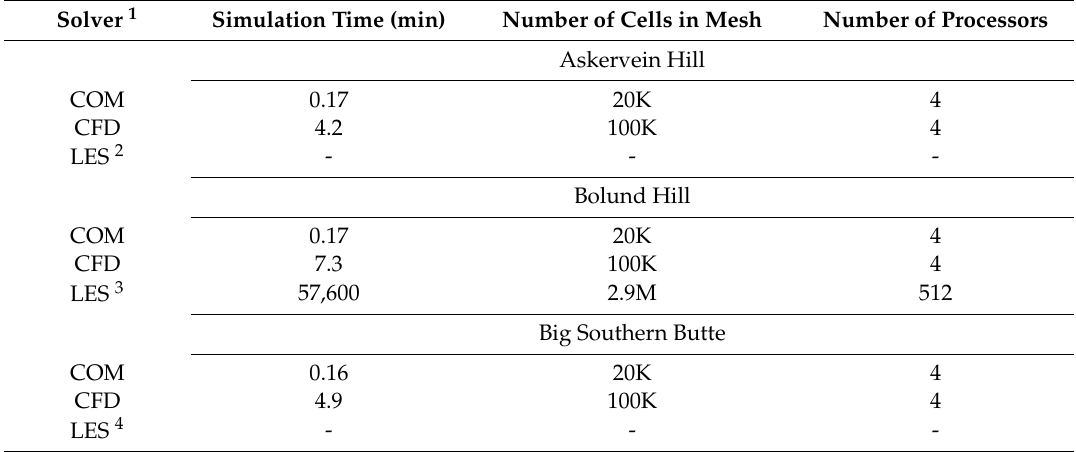
Table 10. Computational expense required for the COM, CFD, and LES